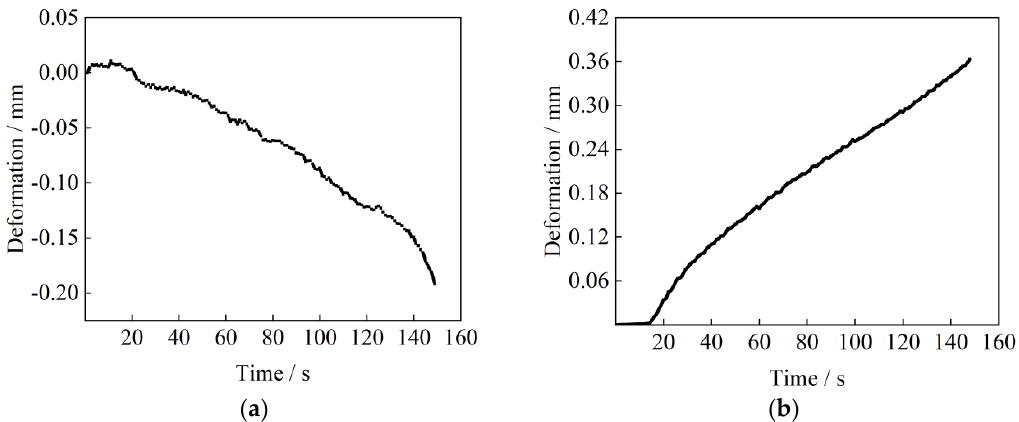
Figure 6. Transverse deformation curve of the concave hexagonal unit cell (A−0−1): ( a ) transverse deformation ΔX; ( b ) longitudinal deformation ΔY.